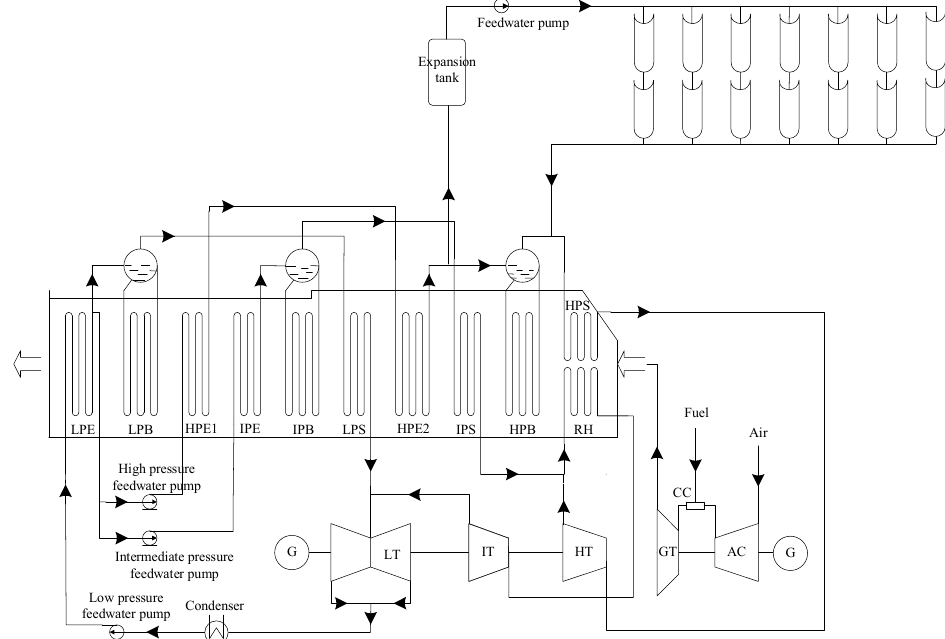
Figure 1. The traditional integrated solar combined cycle (ISCC) system integrated with high pressure boiler